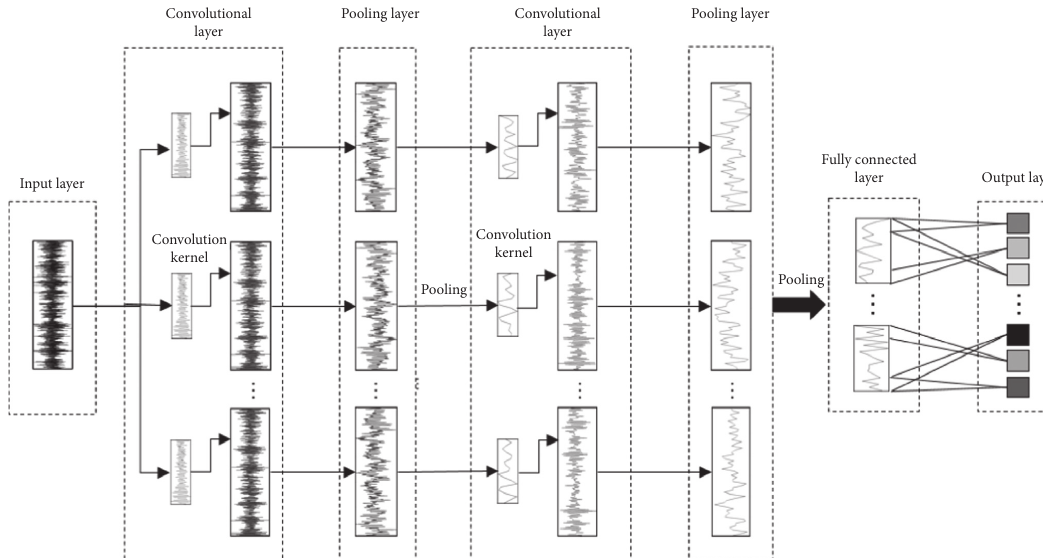
Figure 1: Structure of the 1DCNN.